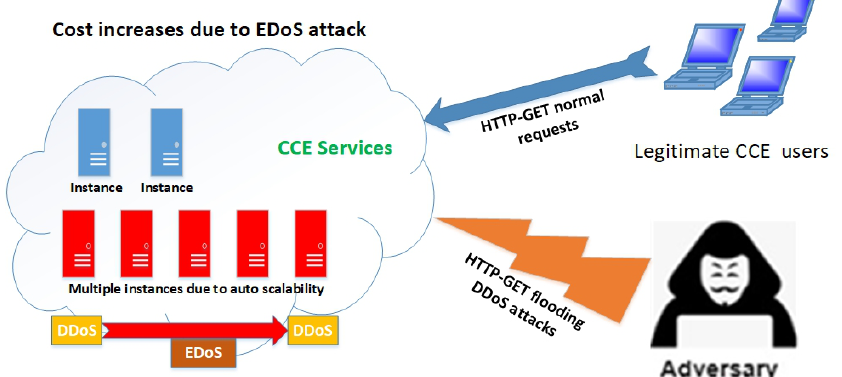
Figure 3. Economic denial of sustainability